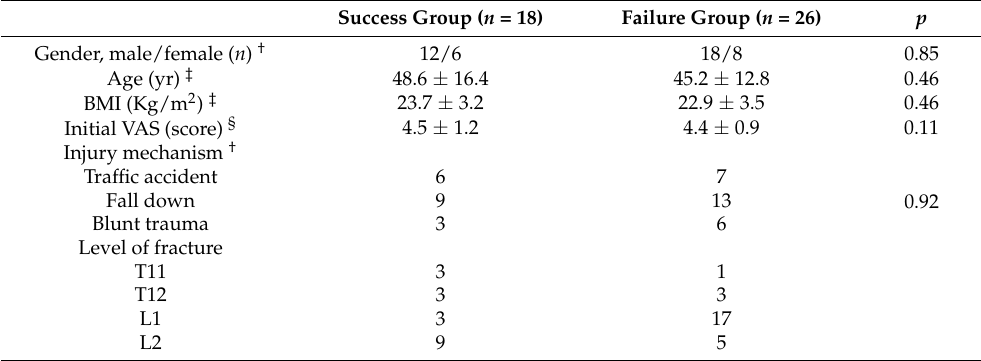
Table 1. Preoperative demographic data.